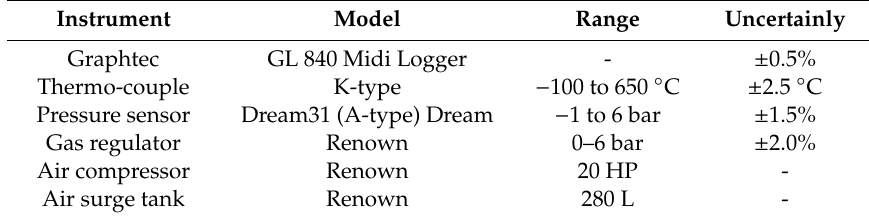
Table 2. Range and uncertainly of the equipment used in the experiment.